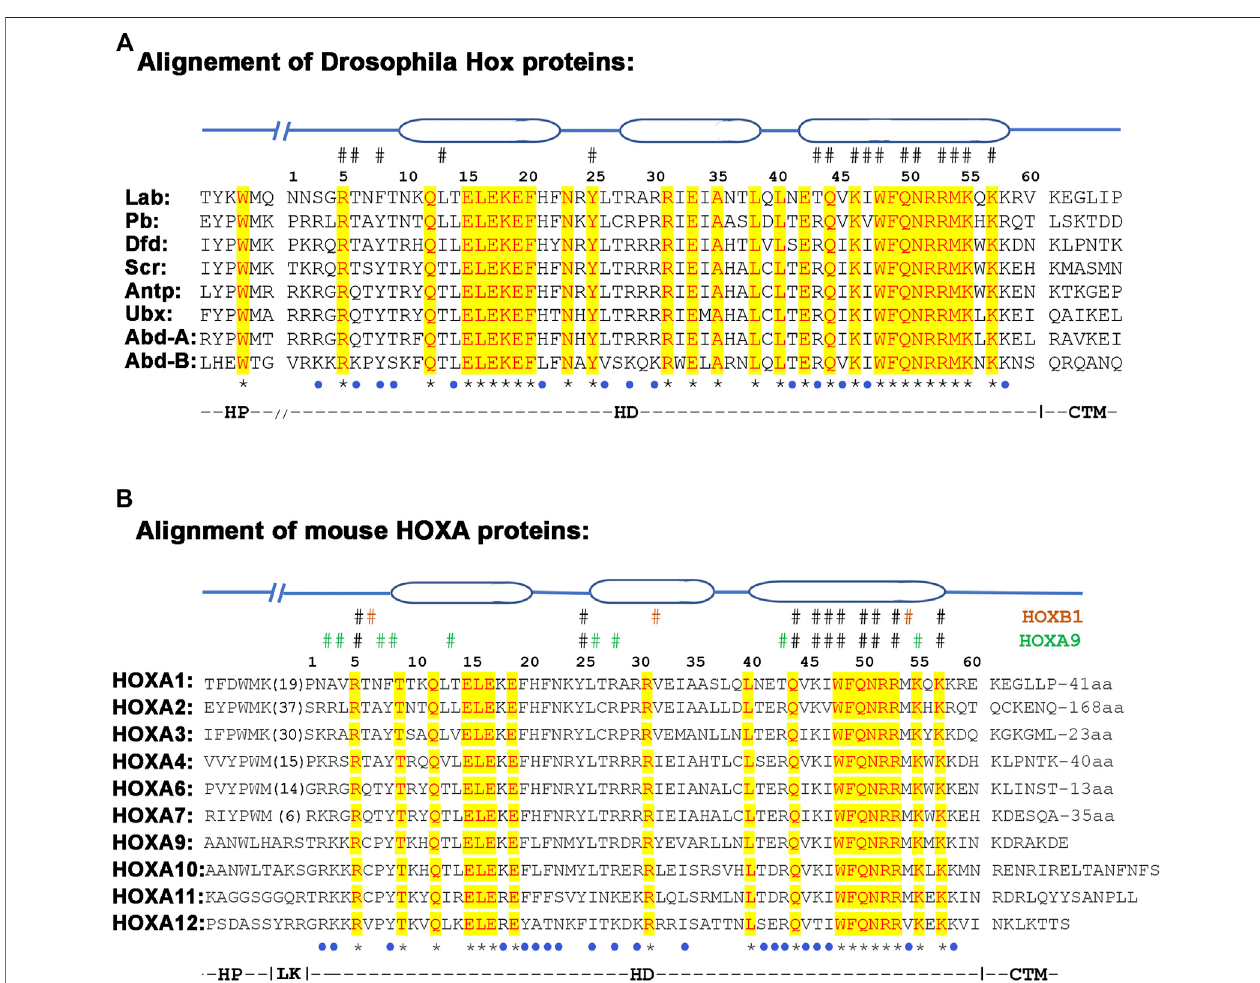
FIGURE 5 | Alignment of hexapeptide (HP), linker (LK), homeodomain (HD) and CTM regions from Drosophila (A) and mouse (B) HOX proteins. The three ovel regions on the top of the alignment shows the position of alpha-helices. The # sign above the alignment depict amino acids that contact DNA, while star (*) and blue dot under the alignment show conservative and semi conservative amino acids